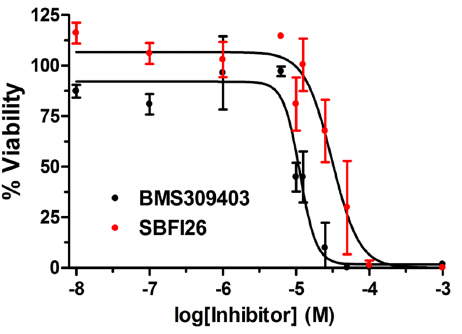
Figure 6. Cytotoxicity of SBFI26 and BMS309403 in HeLa cells. Cells were incubated with the indicated compounds and viability was assessed 24 hrs later. SBFI26 and BMS309403 reduced cell viability with IC